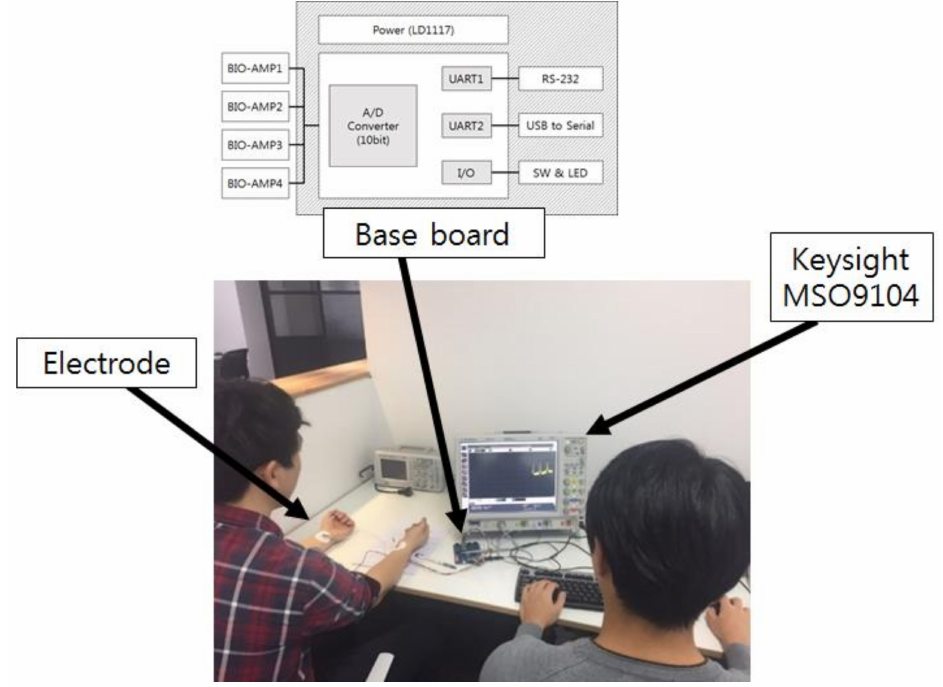
Figure 7. Developed device and environment for measuring ECG